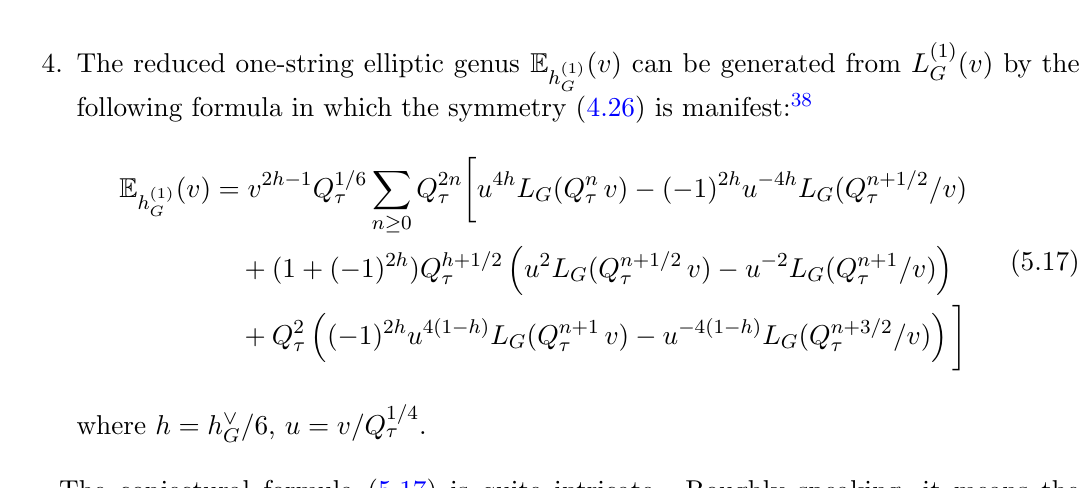
for one SO(8) instanton i;j